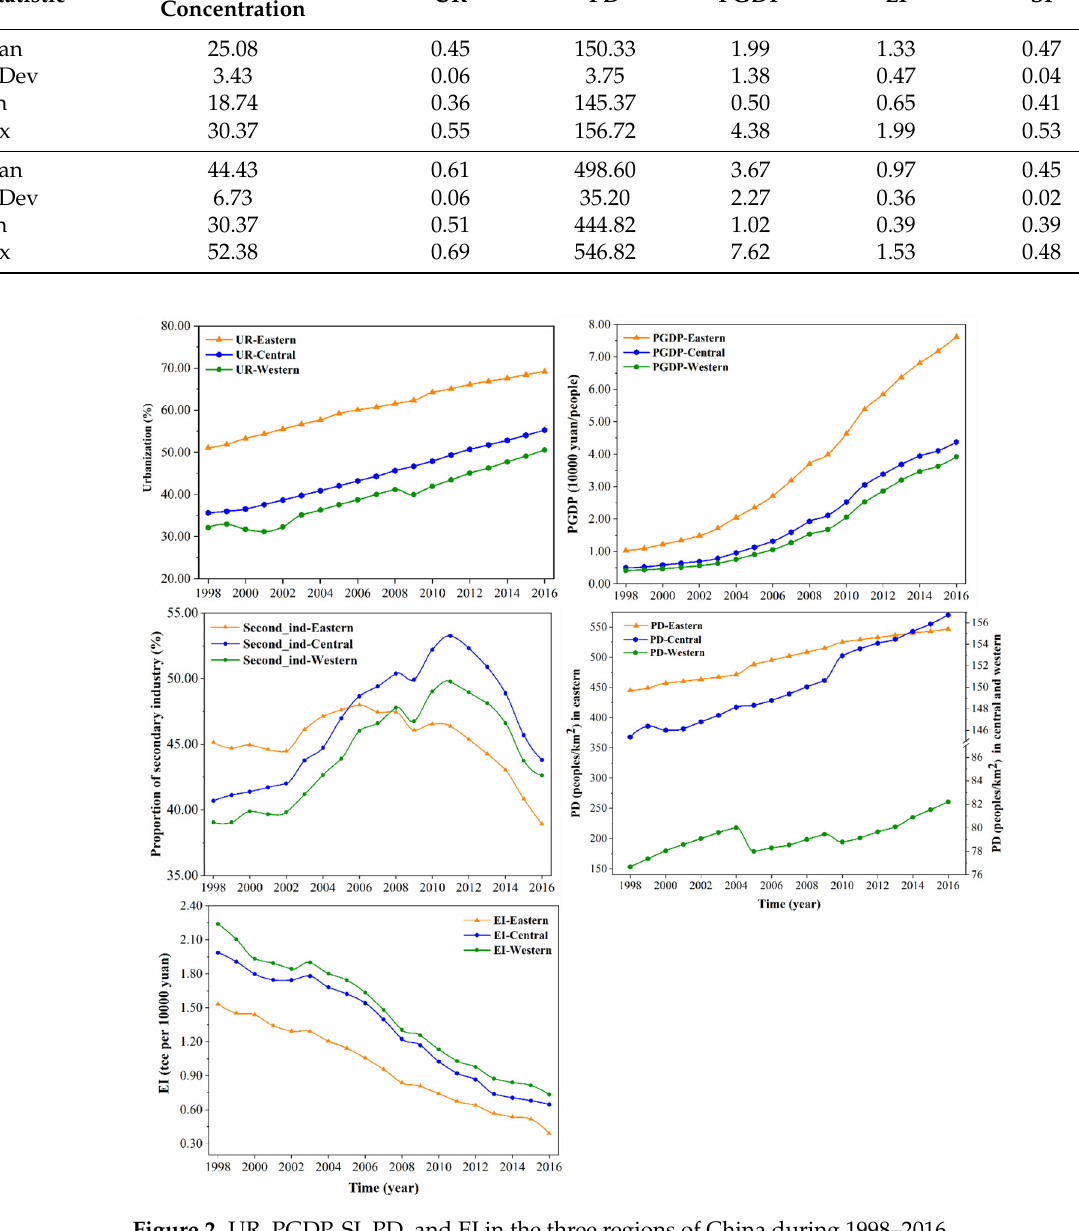
Figure 2. UR, PGDP, SI, PD, and EI in the three regions of China during 1998–2016.